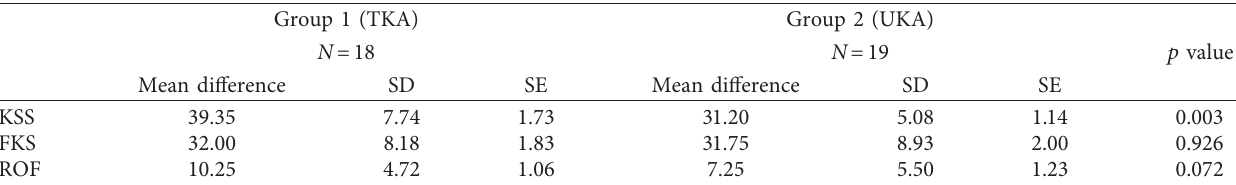
Table 3: Comparison of the difference between the postoperative and preoperative values of Knee Society Score, functional knee score, and the range of flexion in the two